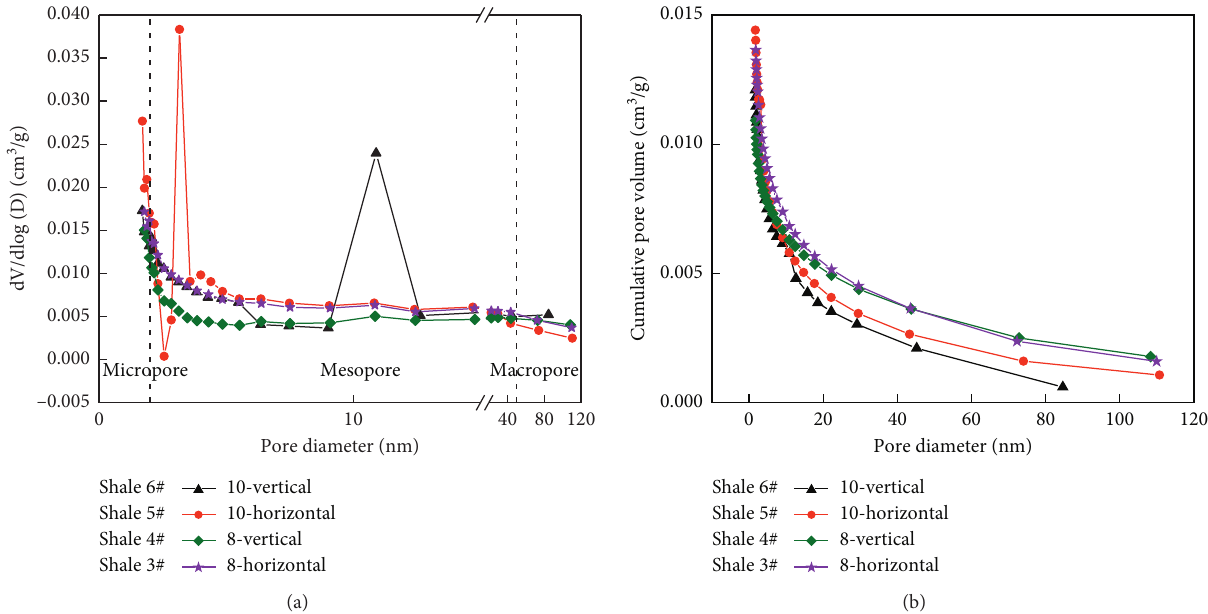
Figure 7: Pore size distribution of shale samples: (a) the relationship between pore size and rate of change of pore volume with the pore size; (b) the relationship between pore volume increment and pore